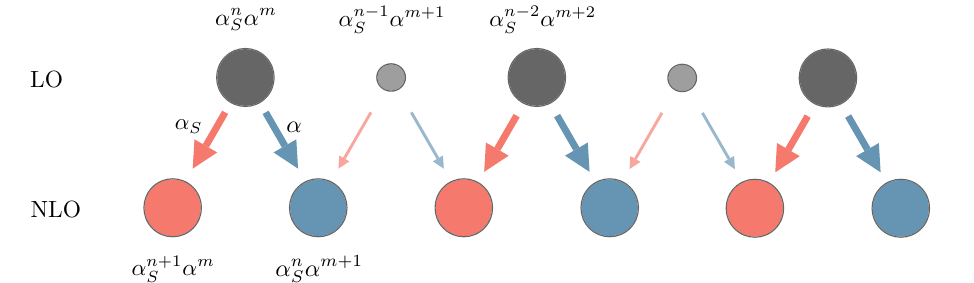
EW (blue) corrections, while each NLO term is connected to a unique squared Born term either via QCD or EW corrections. Apart from the outer most NLO terms of pure QCD and pure EW kind, QCD(EW) corrections to squared Born terms mix with EW(QCD) corrections to adjacent interference